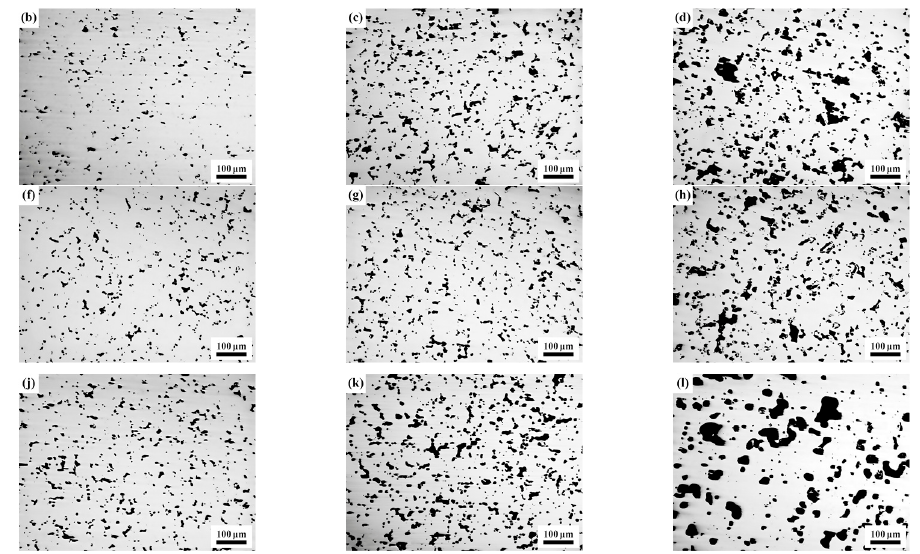
Figure 4. Initial TIP values of the as-HIPed P/M FGH97 superalloys.